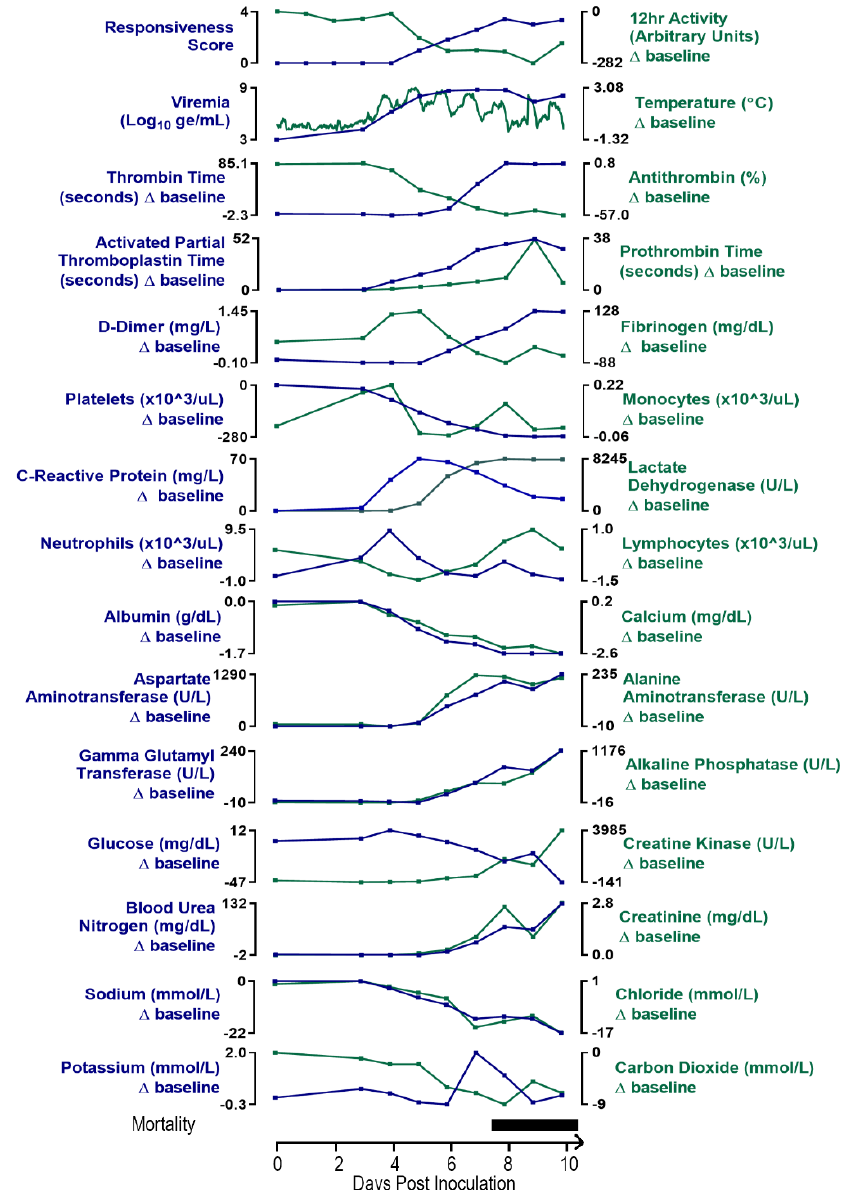
Figure A1. Clinical signs, viremia, and clinical pathology alterations in rhesus macaques exposed to IM EBOV. Data represent the mean for EBOV-exposed animals. Mean responsiveness score was derived from the individual animal maximum daily responsiveness score. The 12-h activity was derived from individual animal physical movements assessed via telemetry, averaged over the 12-h interval corresponding to the animal room light cycle (dark-cycle activity is not shown). For plasma viral RNA concentrations, EBOV RNA values below the LOD were imputed as 3.000 log 10 ge / mL; values above the LOD but below the LLOQ were imputed as 4.903 log 10 ge / mL. Temperature represents 30-min body temperature averages. X-axes are truncated to highlight responses occurring from the first sampling point through the acute disease phase. Error bars were omitted for clarity. The horizontal mortality bar indicates the range of timing in which animals succumbed.